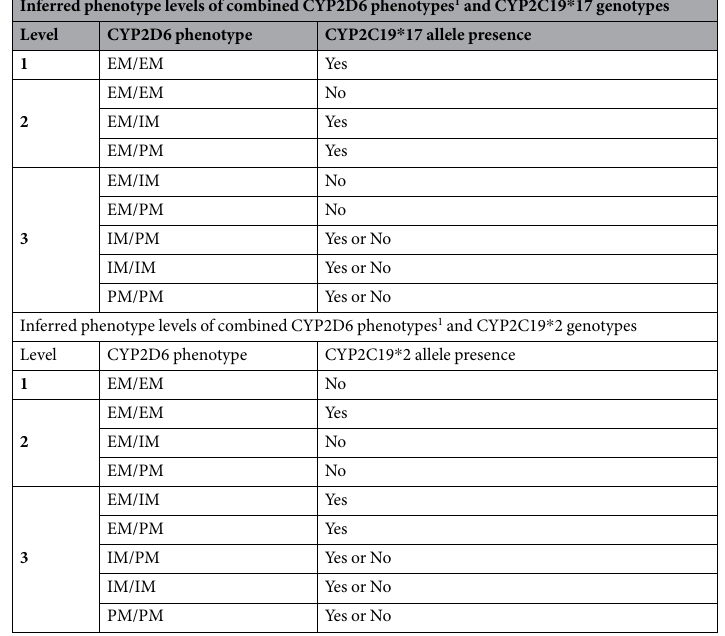
Table 1. Phenotype assignment according to CYP2D6 and CYP2C19 genotype. 1 CYP2D6 UM considered as EM for creation of these